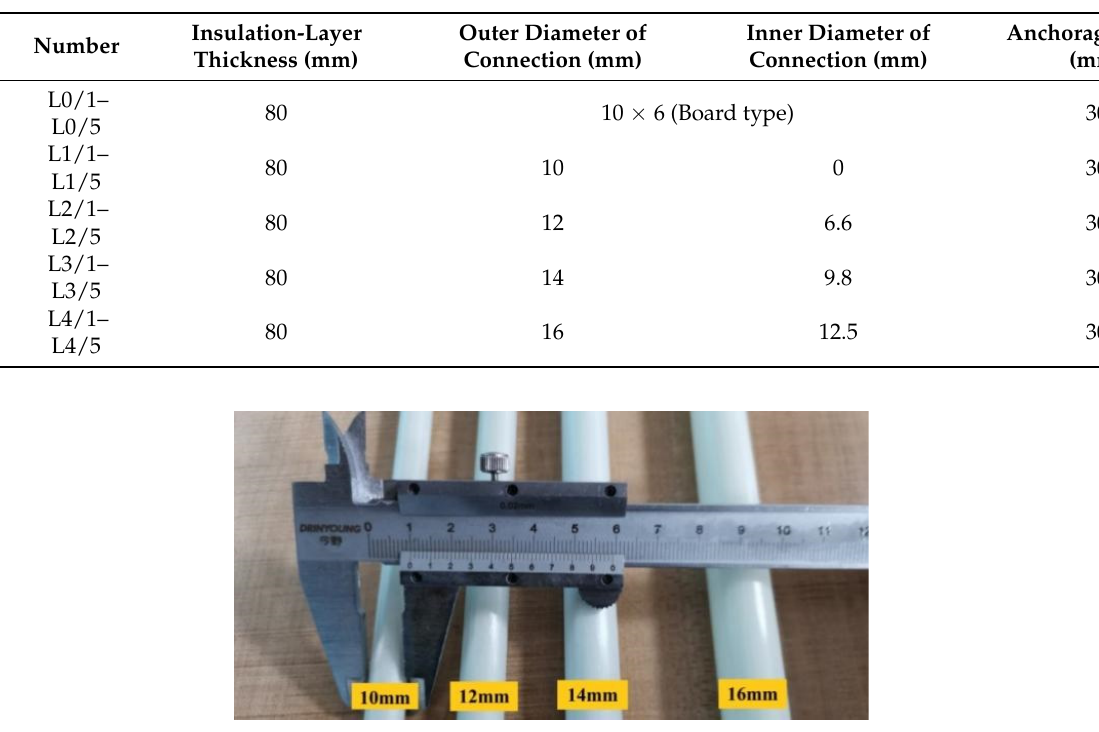
Figure 4. Hollow connecting rods with different outer diameters (Unit: mm).